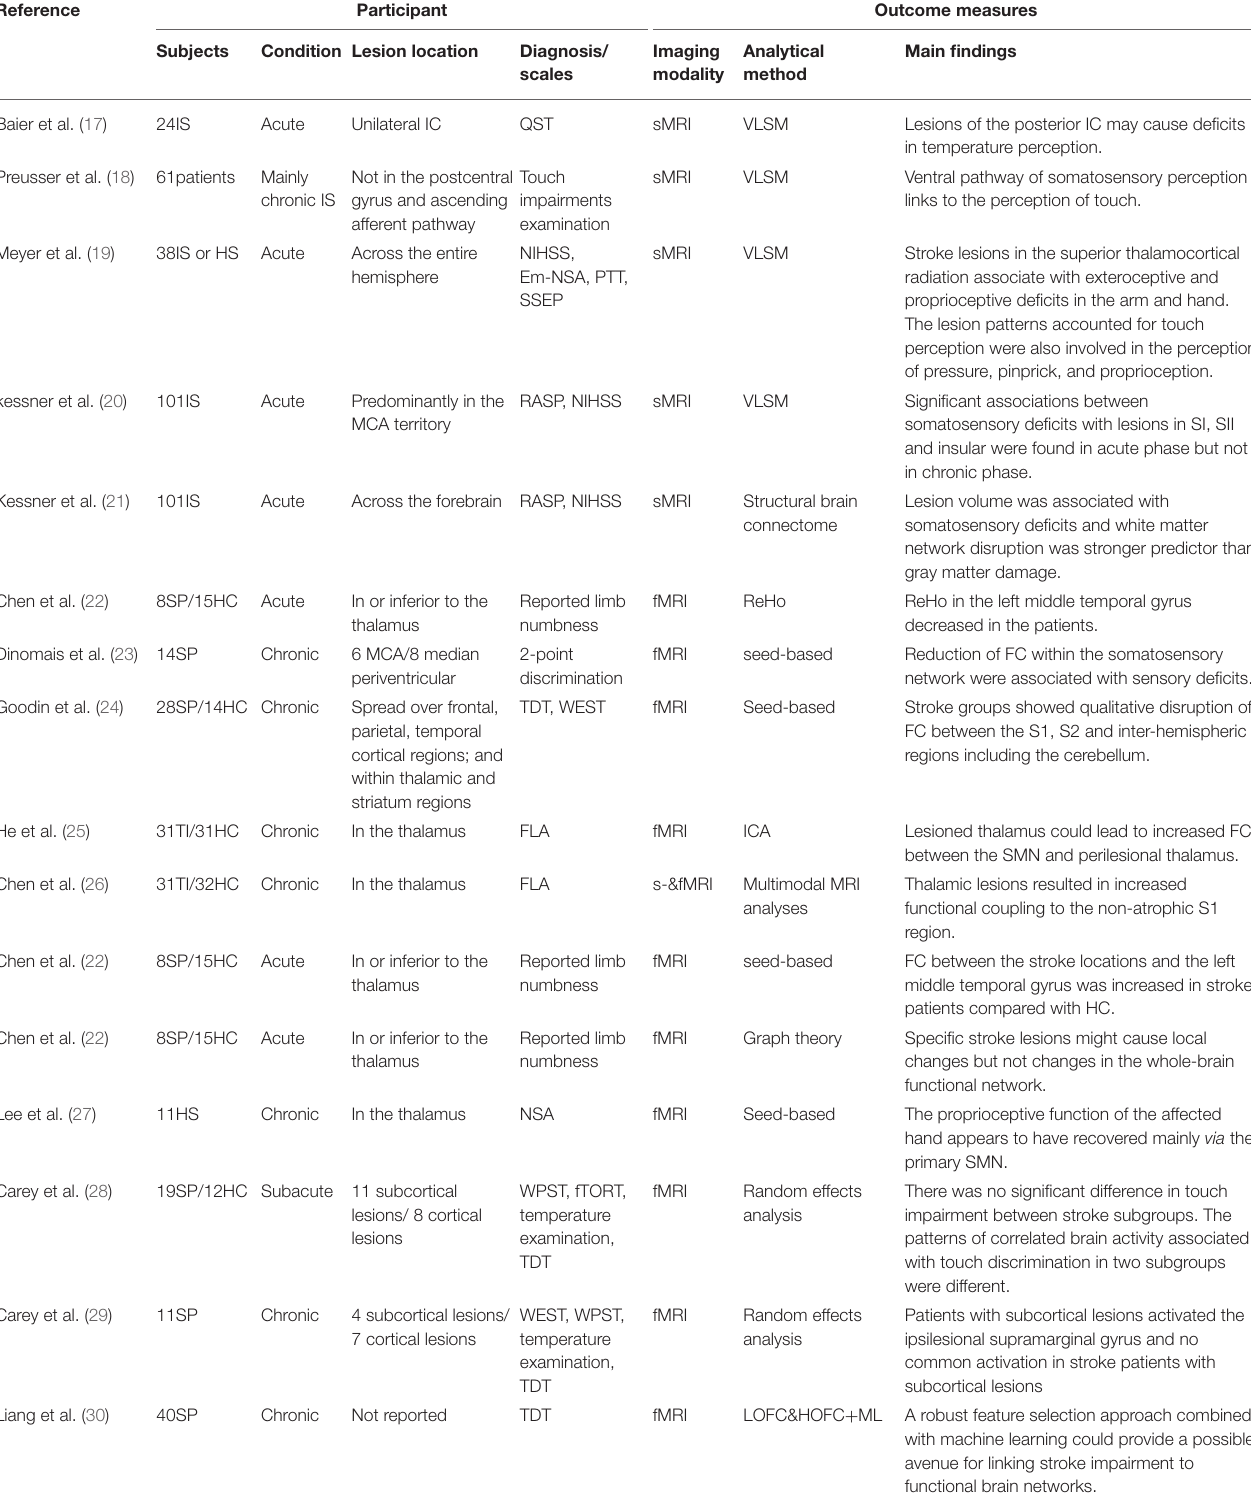
TABLE 1 | Overview of studies reporting MRI findings in stroke patients with somatosensory